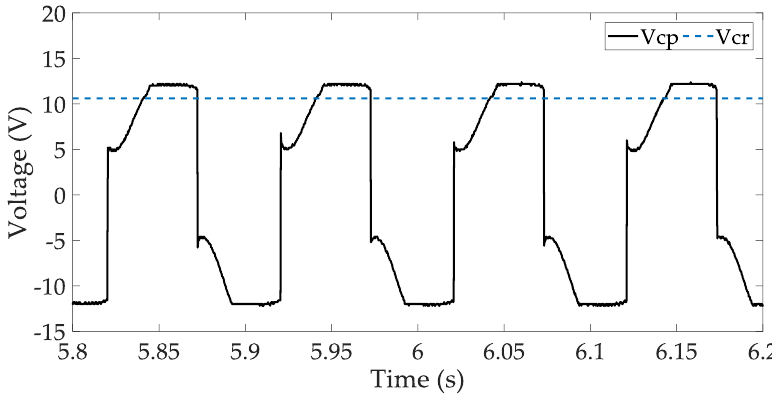
Figure 11. Experimental waveforms of P-SSHI.